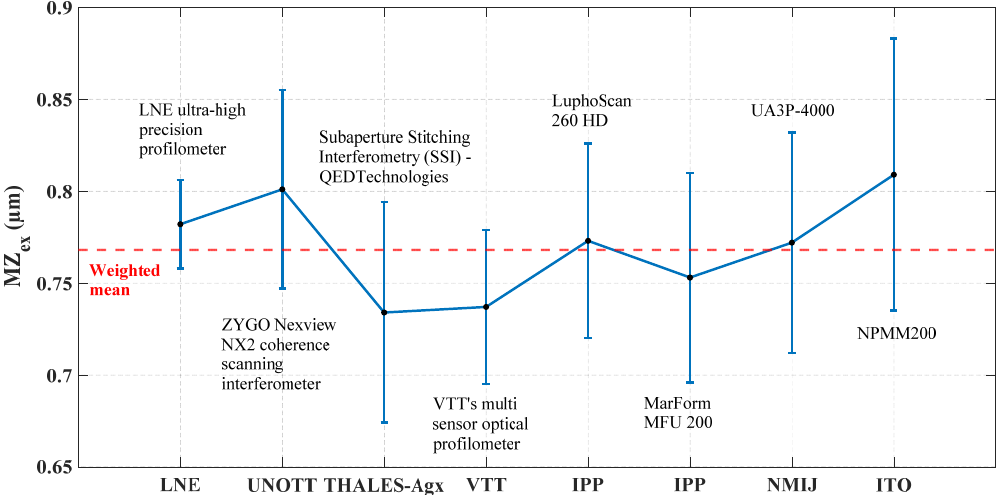
Figure 12. Illustration of the obtained MZ ex values obtained by applying the implemented robust reference minmax fitting algorithm (Hybrid Trust Region) and the estimated expanded standard uncertainties for TIMM-2.